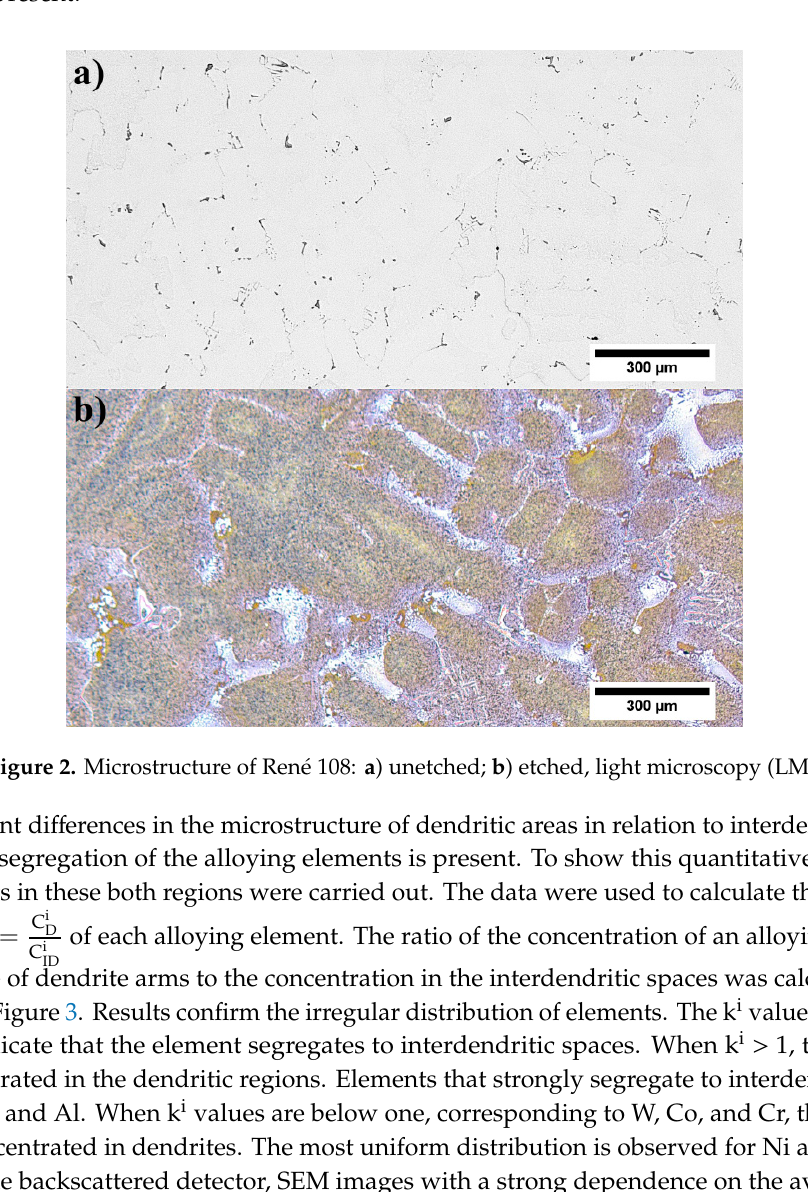
Figure 3. Segregation coefficient k (cid:2919) = (cid:2887) (cid:3136)(cid:3167) (cid:2887) (cid:3141)(cid:3136)(cid:3167) of selected alloying elements. Using the backscattered detector, SEM images with a strong dependence on the average atomic number Z were obtained. The microstructure of the γ ' in dendritic regions is presented in Figure 4. Large secondary γ ' precipitates are characterised by a complex morphology. Locally at their edges